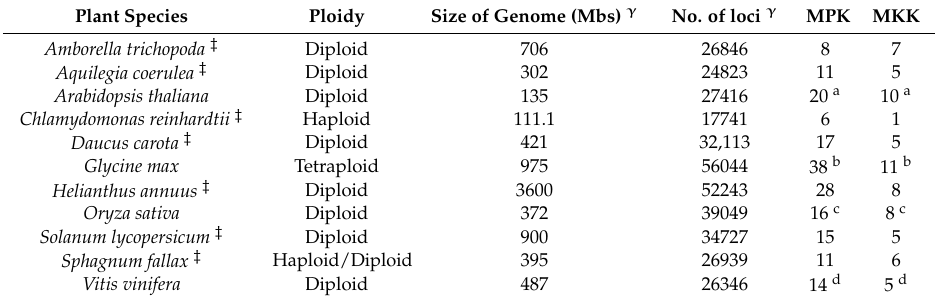
Table 1. Abundance of MPK and MKK genes in the genomes of 11 species used in this study. Plant